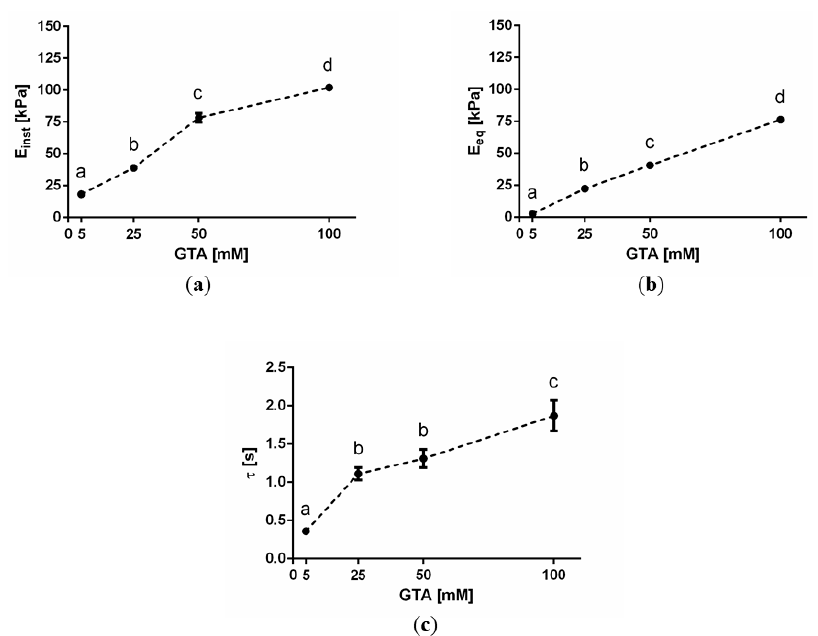
Figure 2. ( a ) Instantaneous ( E inst ) and ( b ) equilibrium ( E eq ) elastic moduli as well as ( c ) characteristic relaxation times ( τ ) as a function of glutaraldehyde (GTA) concentration obtained by globally fitting experimental nano-indentation stress-time data recorded at different constant strain rates to a Maxwell SLS lumped parameter model, as per the nano- ε M . The error bars denote standard errors of estimation. Different letters indicate significant differences between samples (one-way ANOVA, p < 0.05), whereas the same letter means non-significant differences.